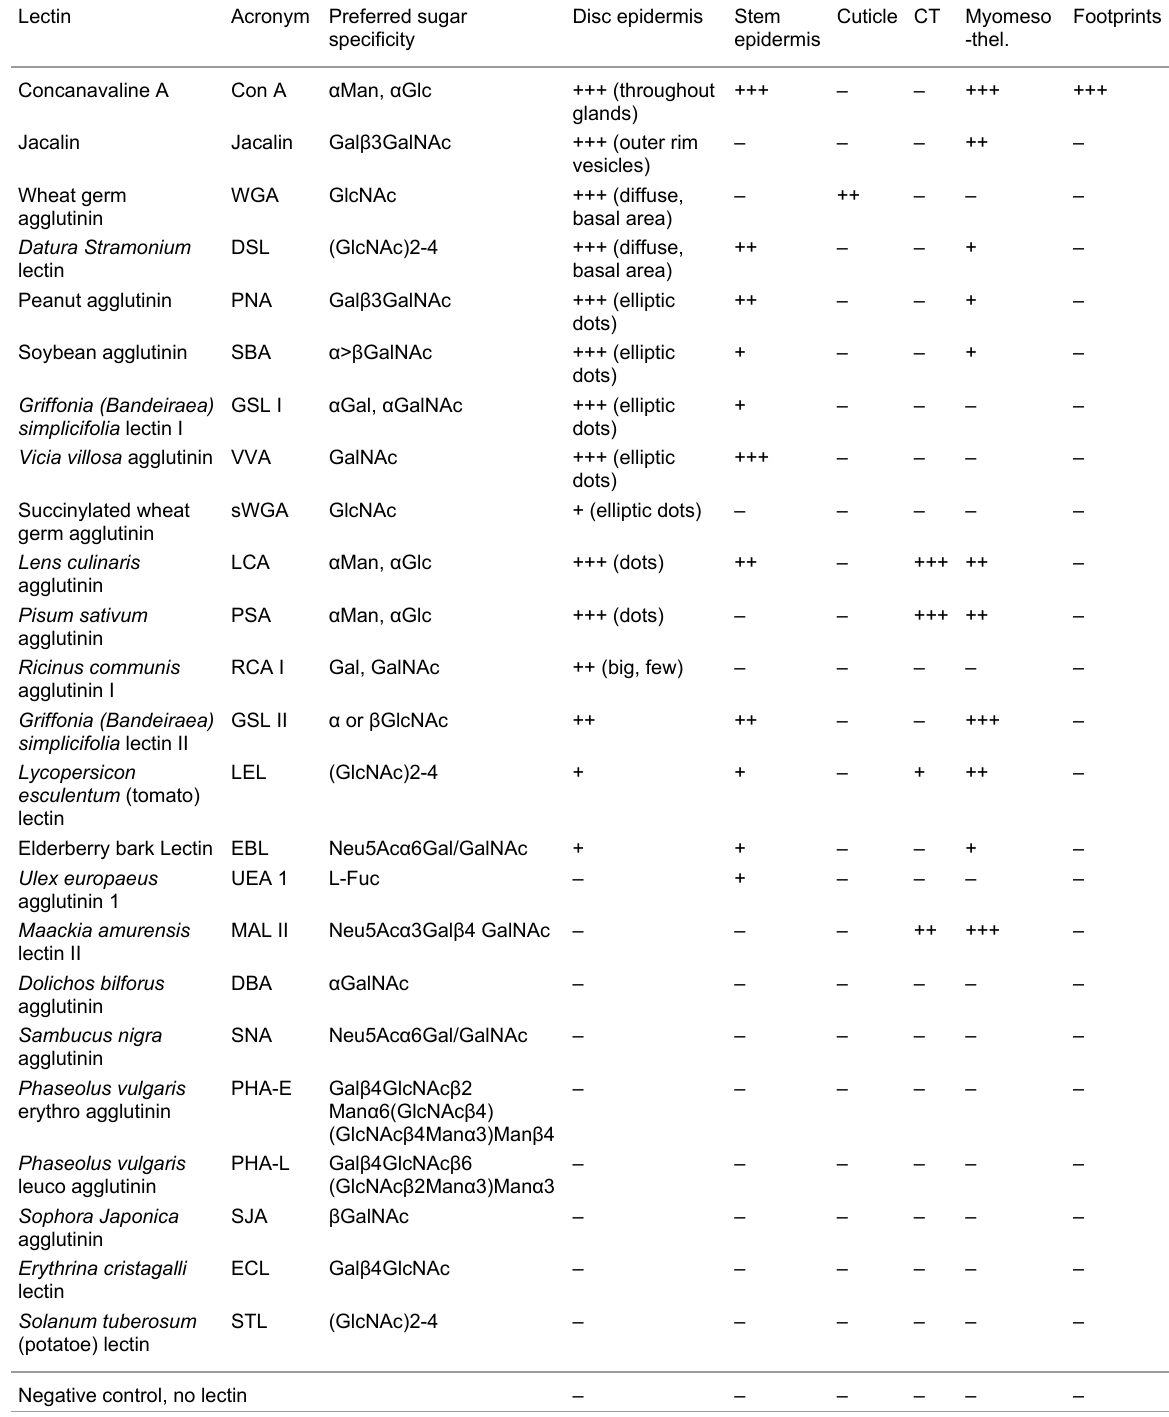
Table 1: Overview of lectin labelling in Asterina gibbosa tube feet and footprints.